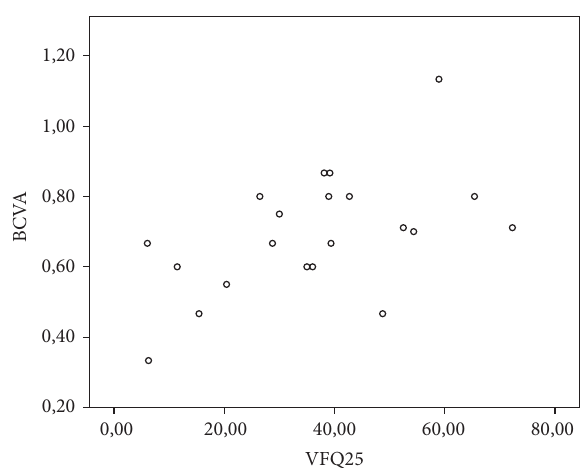
Figure 7: Scatterplot showing the significant correlation between BCVA and total questionnaire score as per the Spearman coefficient of 0.508 ( 𝑝 = 0.009 ).